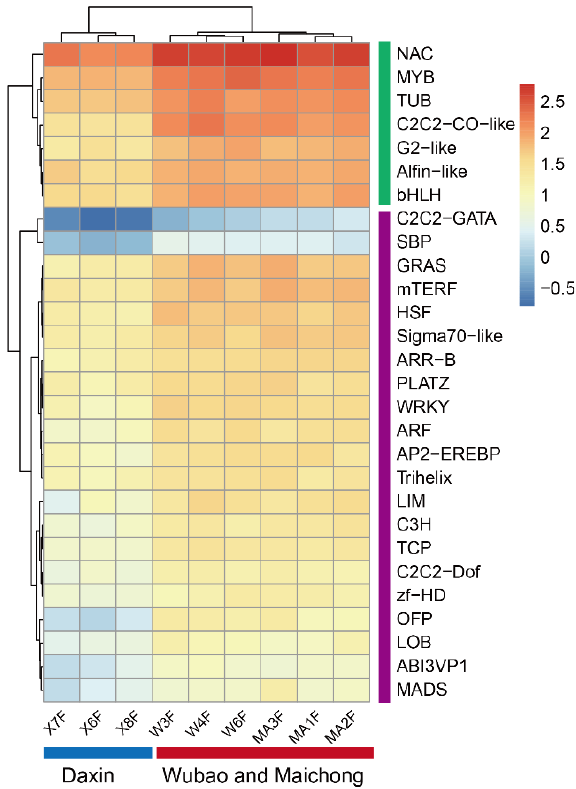
Figure A5. Heatmap base on the expression of TFs.